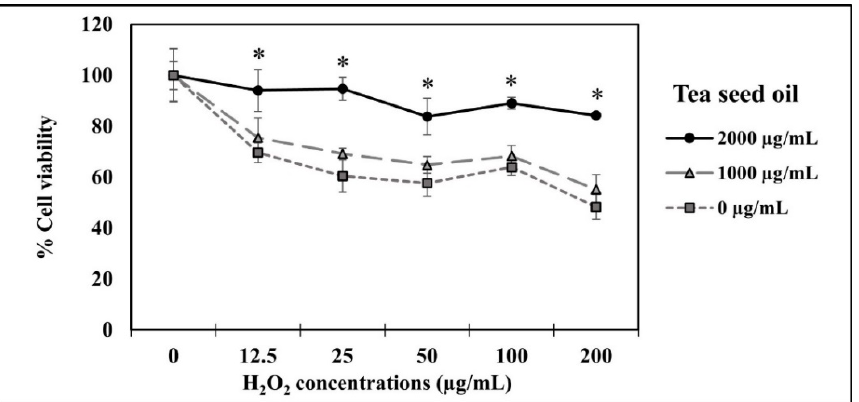
Figure 1. Effects of tea seed oil on protecting HFDP cells from free radicals induced by H 2 O 2. (* indicates statistical significance at p < 0.05).